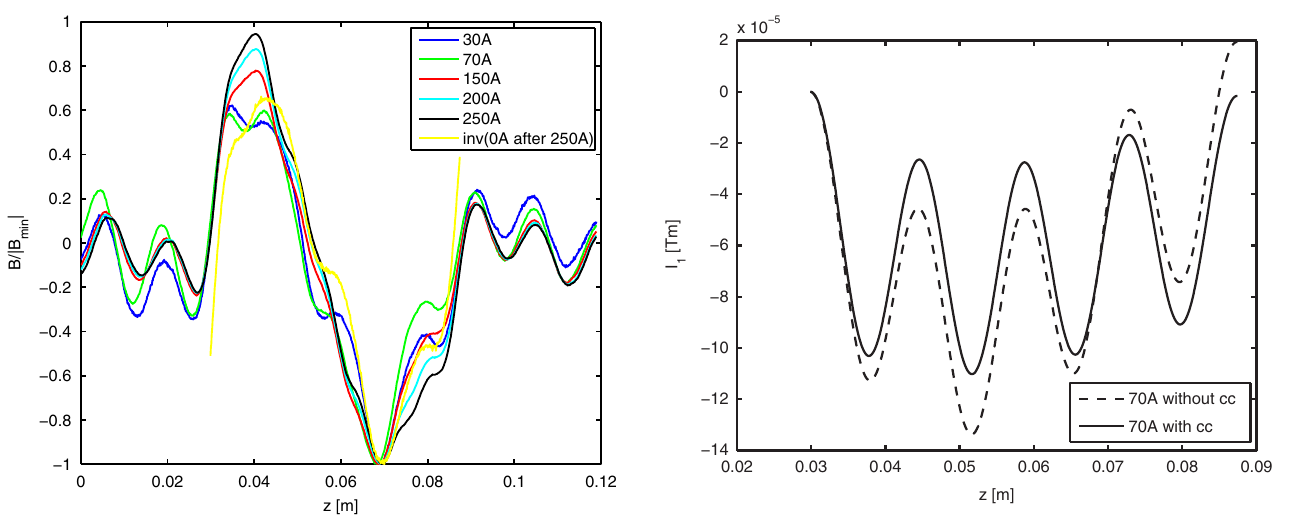
FIG. 7. (Color) Normalized field changes by the YBCO loops for the different mock-up currents shown in Fig. 6 together with the inverted remanent field after switching the mock-up current from I main ¼ 250 to 0